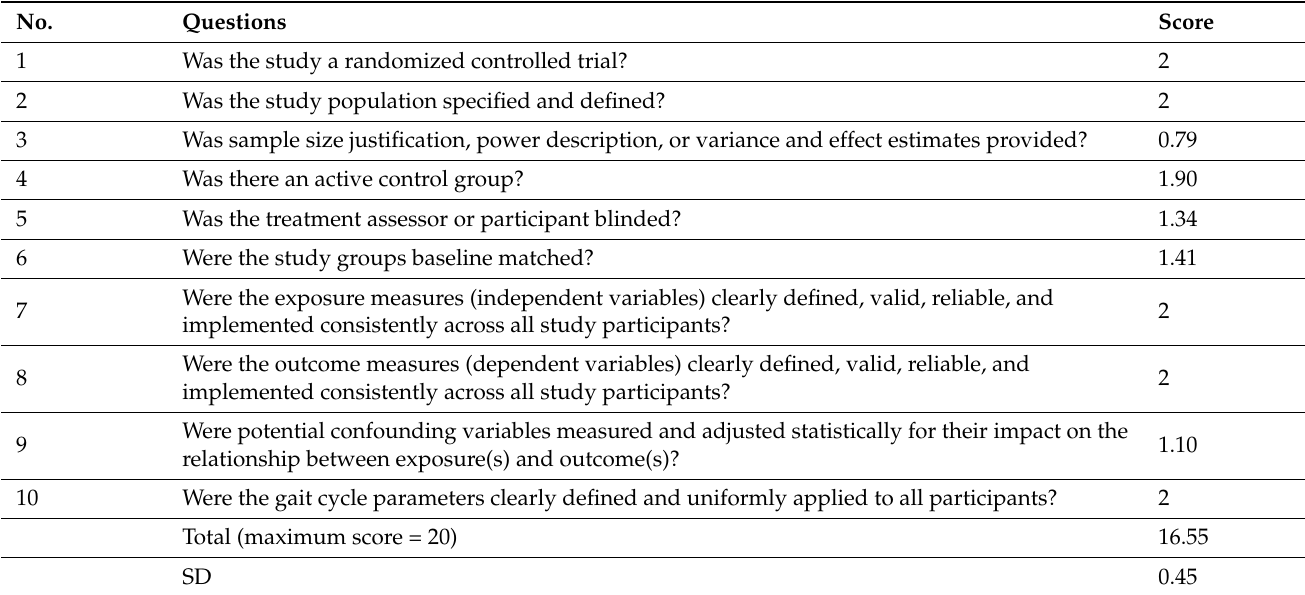
Table 4. Study quality